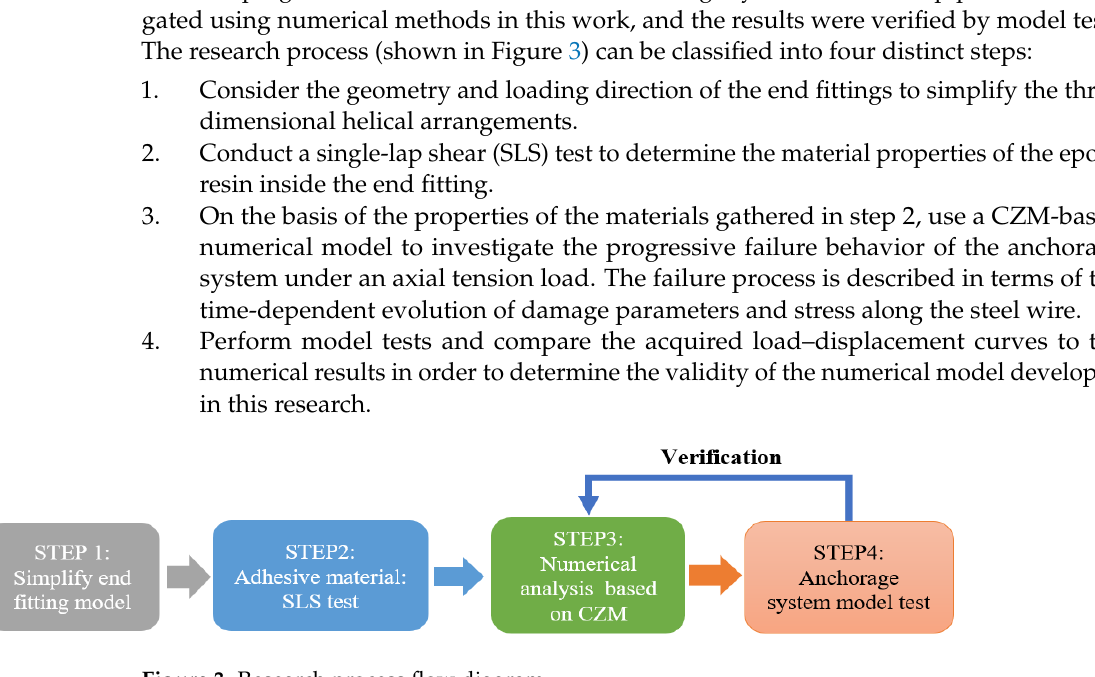
Figure 3. Research process flow diagram.